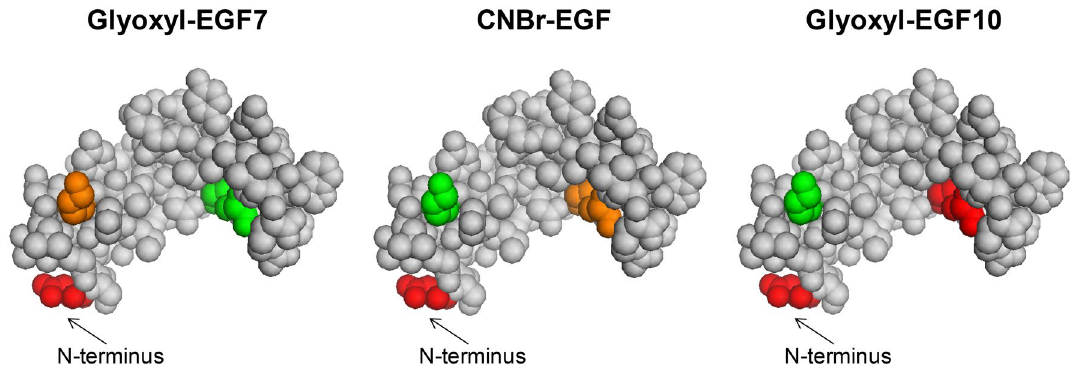
Figure 5. Relative abundance of N -terminus and Lys residues obtained by peptide mapping of free amino acids in EGF immobilized on different carriers. Colors indicate the percentage abundance of each residue. The following legend was used: red 0–20%; orange 20–40%; yellow 40–60%; green 60–100%. Consequently, red = Lys bound to the carrier; green = Lys exposed on the surface, not involved in the binding. Created with